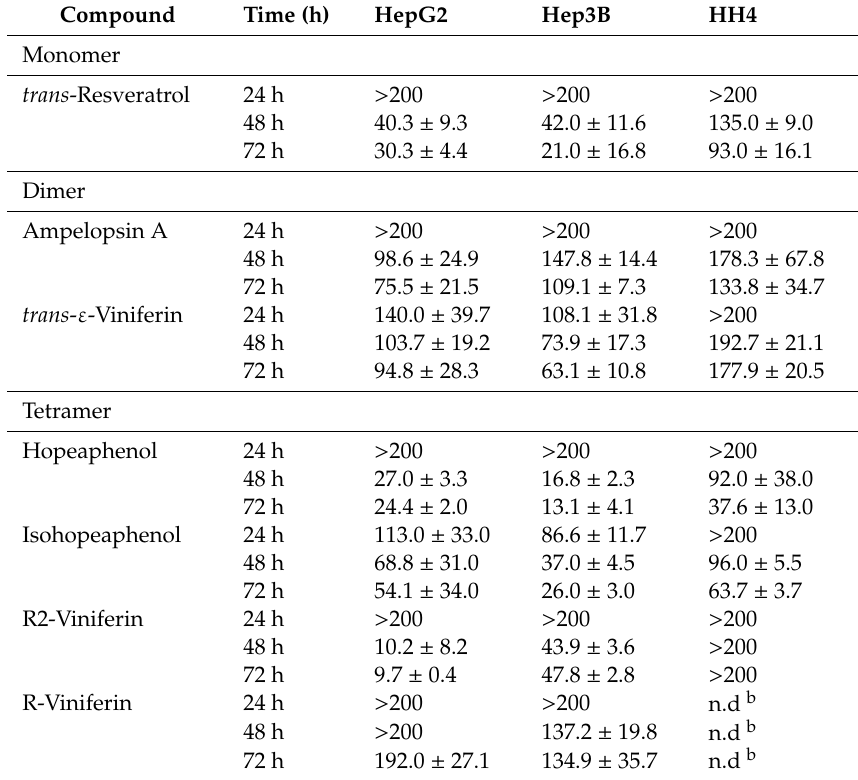
Table 1. IC 50 a values ( µ M) of di ff erent stilbenes against hepatocellular carcinoma cell lines.